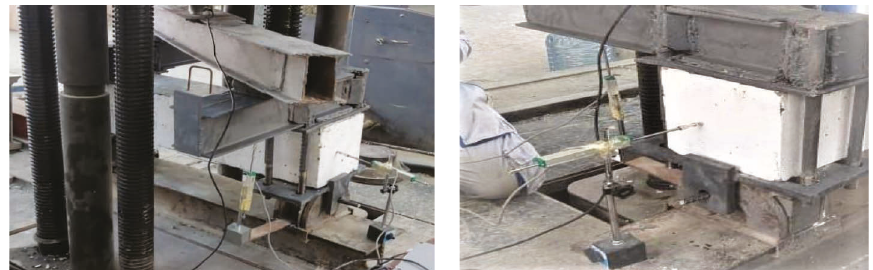
Figure 6: Location of LDVTs.